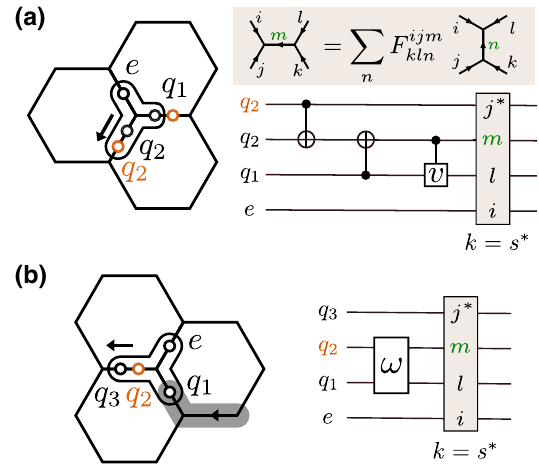
FIG. 14. The quantum circuits for the non-Abelian open-string operators. The orange color highlights the qudits that store the ancillary qudit states. (a) A circuit realization for preparing non- Abelian anyons. The shaded box shows the F move defined by the F symbol in the non-Abelian model, together with the label- ing convention for the F symbol. The shaded circuit elements are qudit quantum gates that perform the F move. The gates are con- trolled single-qudit rotations that change the state of the green qudit labeled with m . The gates are controlled by the states of the other input qudits, each of which is assigned with a label in the F symbol according to the circuit diagram. (b) A circuit realization for moving the non-Abelian anyons by extending the open-string operator (dark